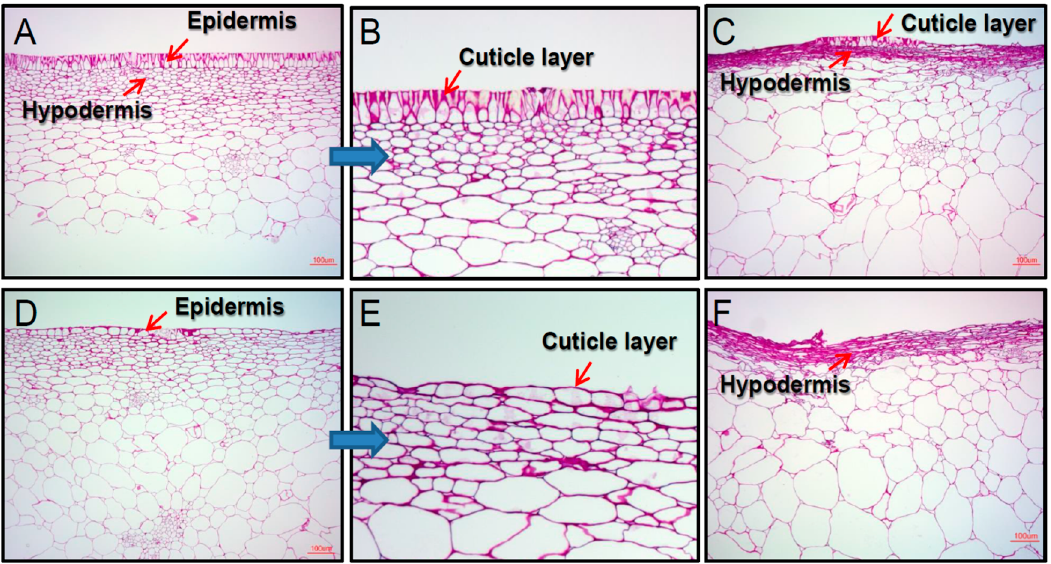
Figure 4. Anatomical analysis of oriental melon peel and suture. Light microscope images of yellow peel tissue: ( A ), normal tissue; ( B ), amplified of image ( A ); and ( C ), browning symptom tissue. Light microscope images of white linear suture tissue: ( D ), normal tissue; ( E ), amplified of image ( D ); and ( F ), browning symptom tissue.